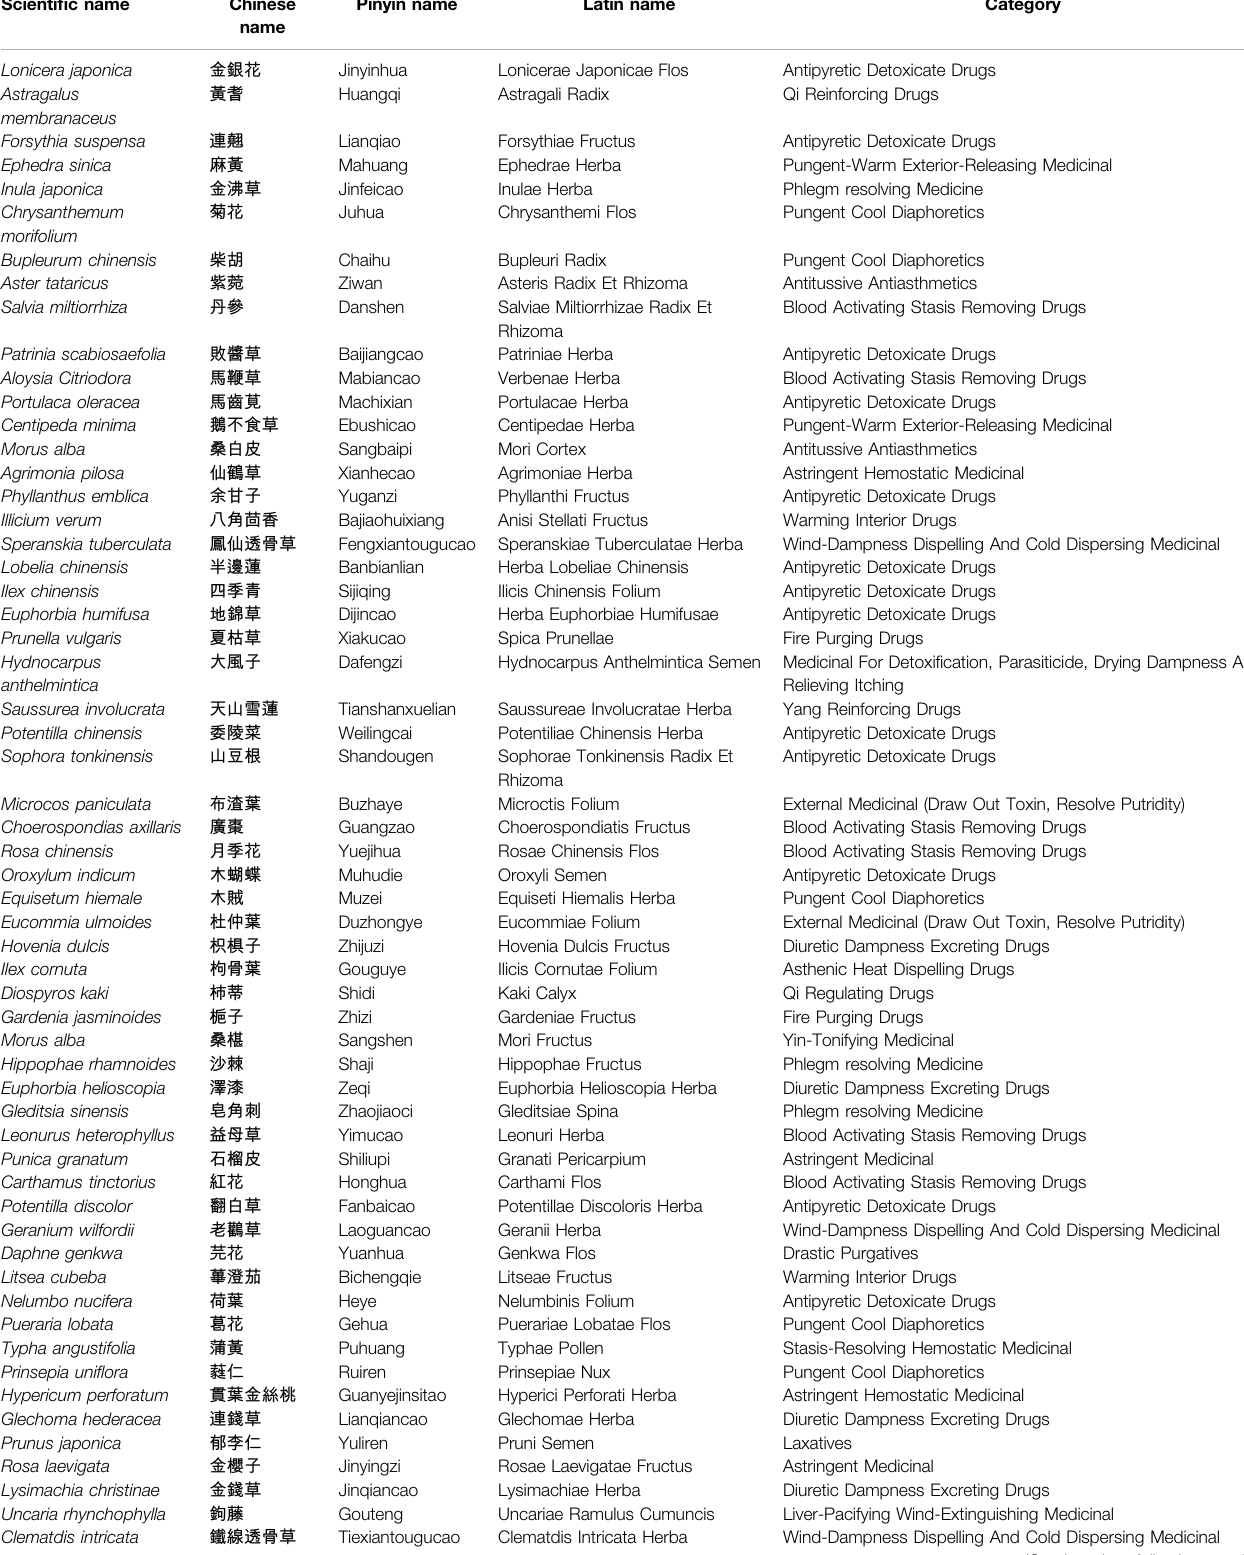
TABLE 2 | The scienti fi c name, Chinese name, and therapeutic category of the TCM candidates predicted to have anti-SARS-CoV-2